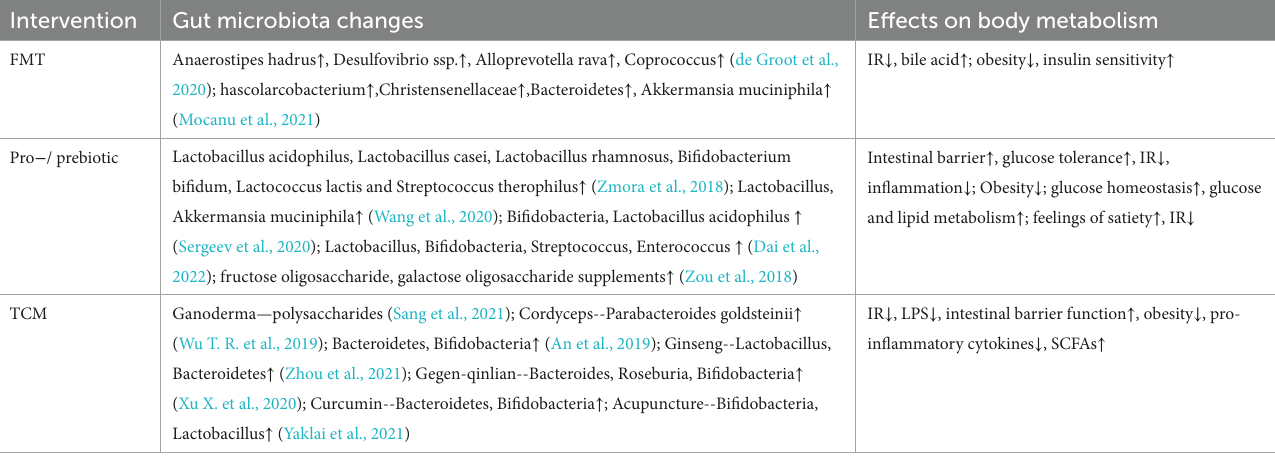
TABLE 4 Effects of different interventions on gut microbiota and metabolism. Intervention Gut microbiota changes Effects on body